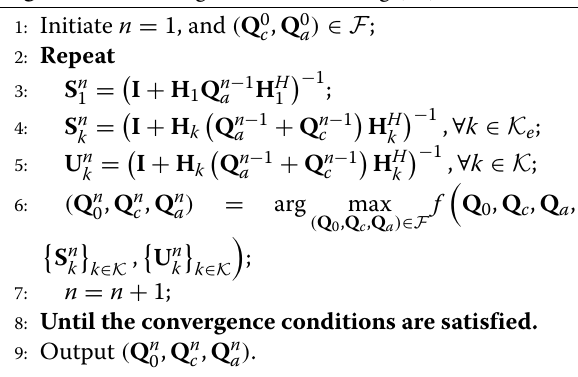
Algorithm 2 AO algorithm for solving